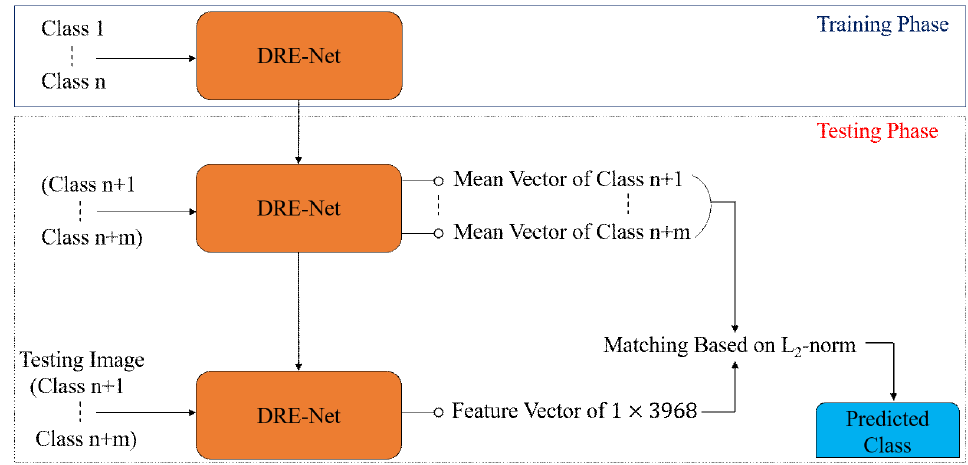
Figure 6. Diagram of open-world configuration for feature extraction and classification.